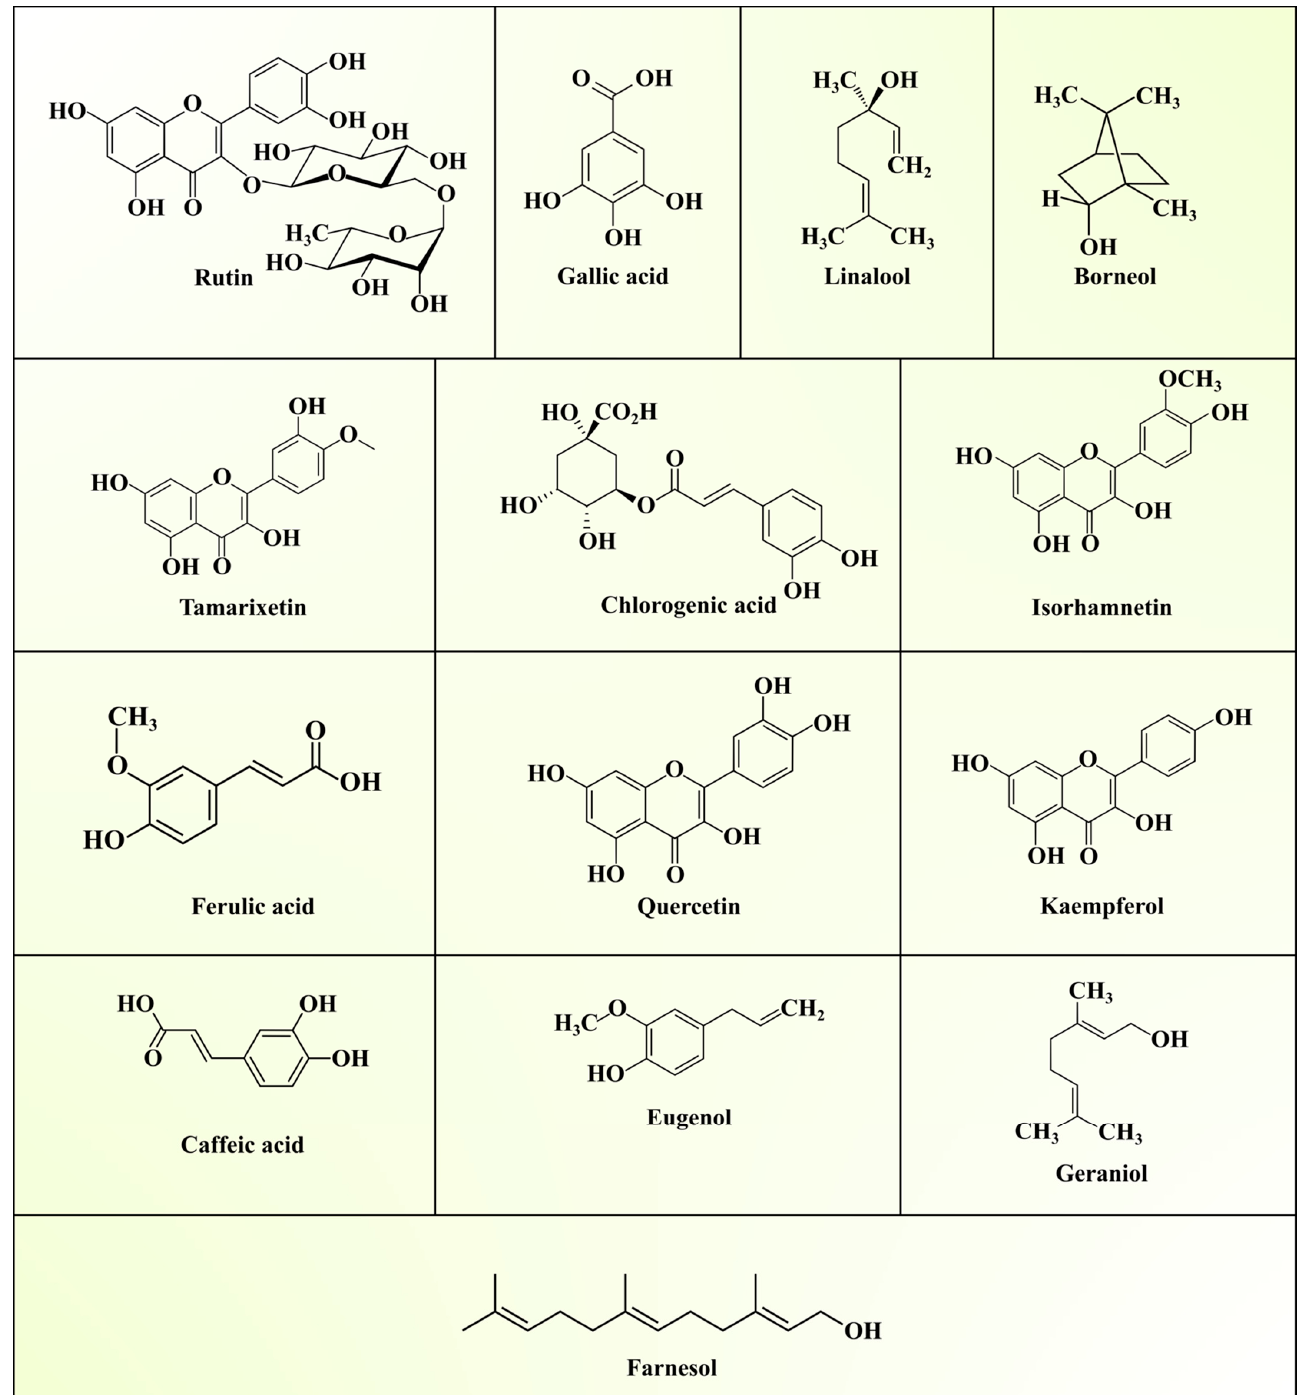
Figure 3. Major phytochemicals from Annona squamosa L.